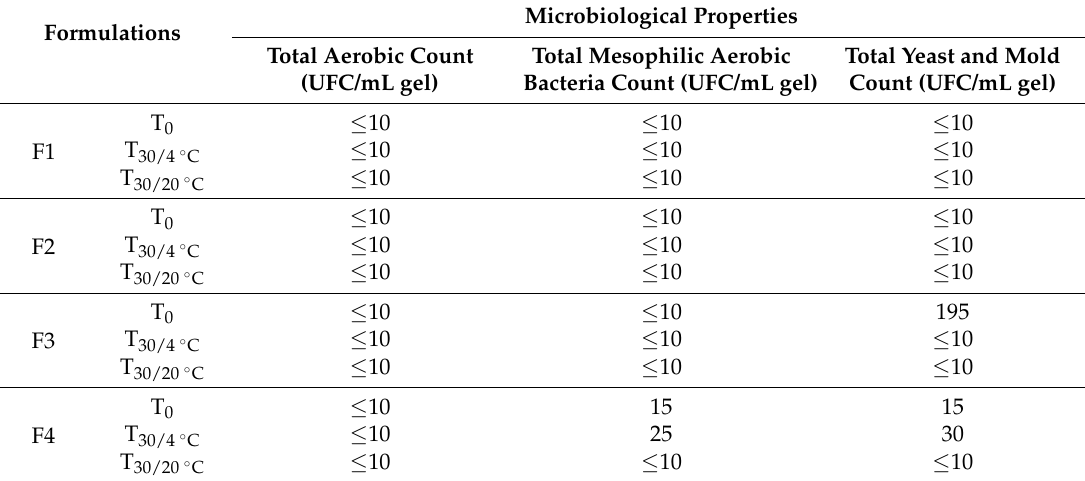
Table 4. Total aerobic, total mesophilic aerobic bacteria and total yeast and mould counts of hydrogels containing chestnut bur extracts in different percentages, evaluated at T 0 , T 30/4 ◦ C and T 30/20 ◦ C . T 0